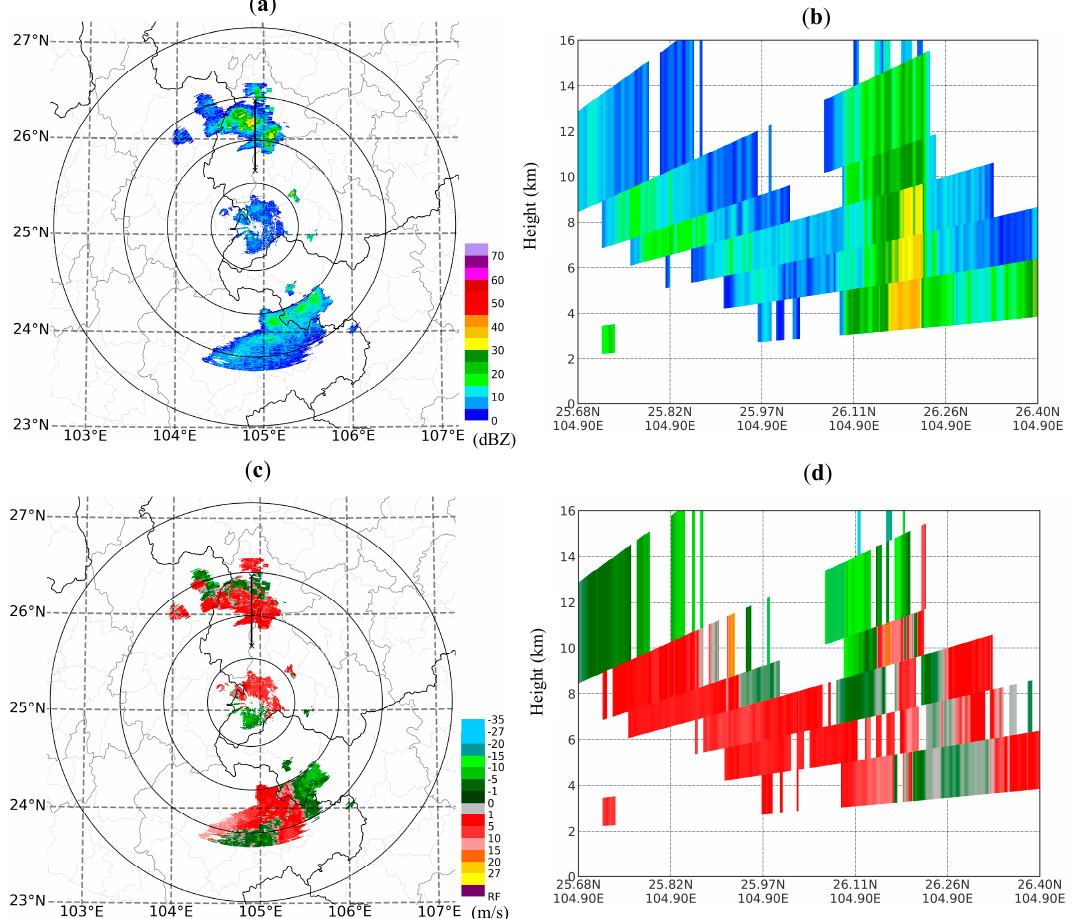
Figure 7. ( a ) Plan Position Indicator (PPI) reflectivity data and ( c ) radial velocity data collected by the Xingyi Doppler weather radar at an elevation of 1.5° at 13:40 UTC on 22 July 2019. ( b ) Range Height Indicator (RHI) reflectivity and ( d ) radial velocity vertical cross-section along the solid lines in ( a , c ).